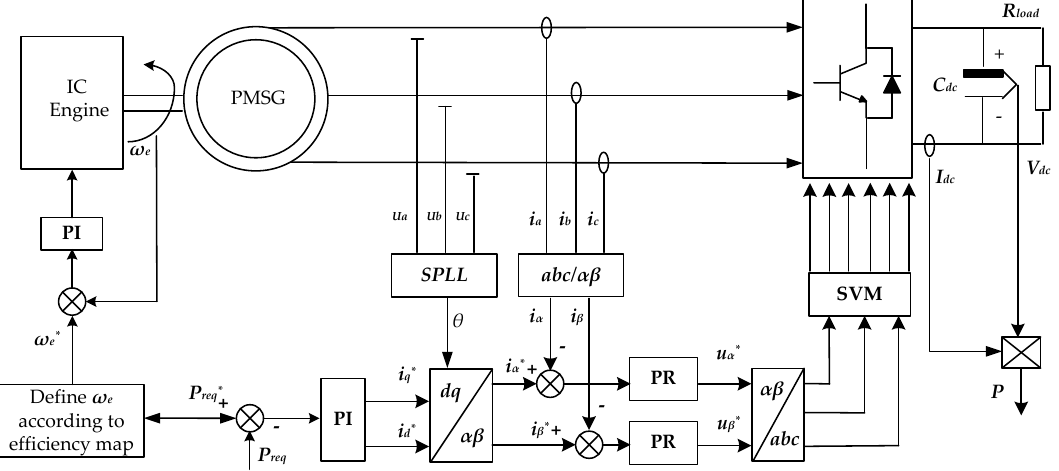
Figure 7. Power following vector control strategy with PR controller.